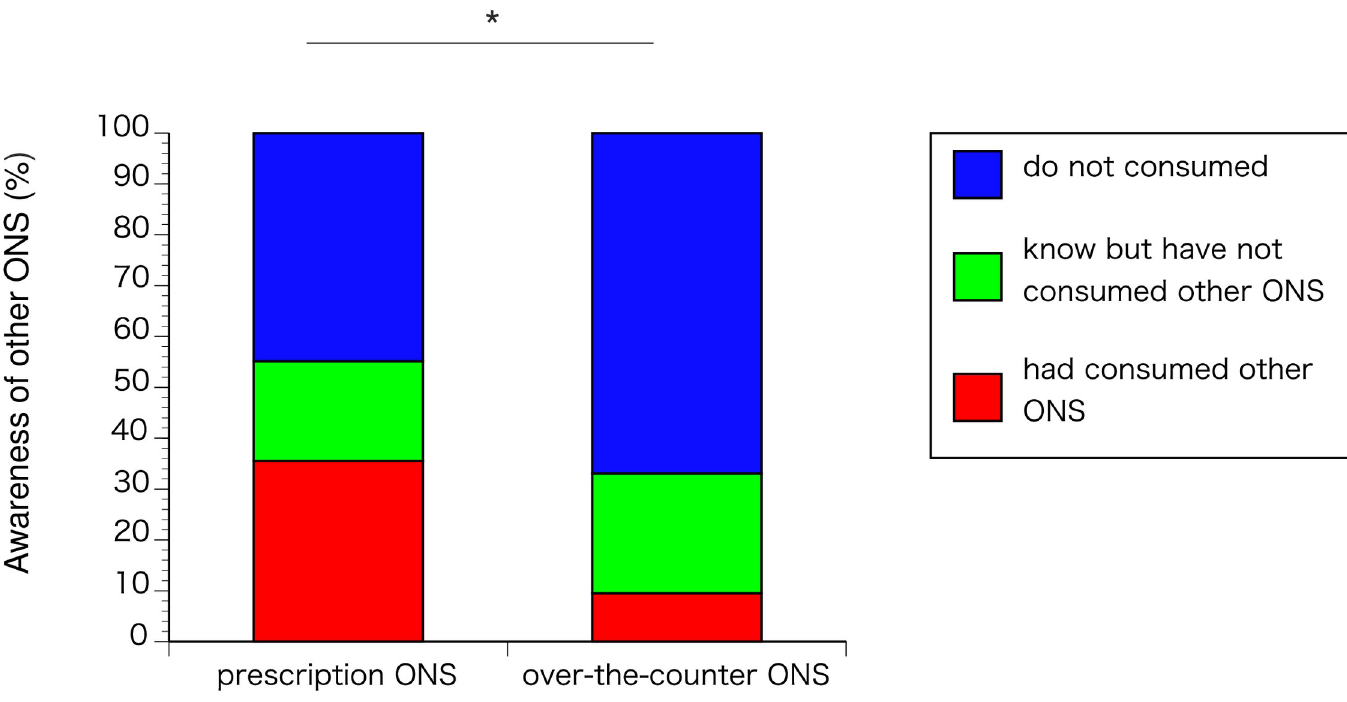
PLOS ONE | https://doi.org/10.1371/journal.pone.0222972 September 26,